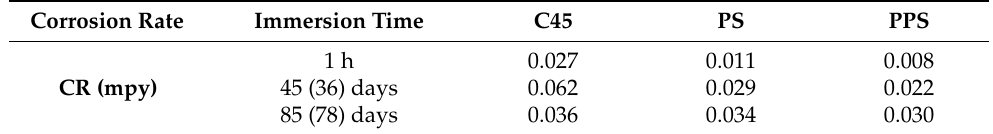
Table 8. The corrosion rate of the studied